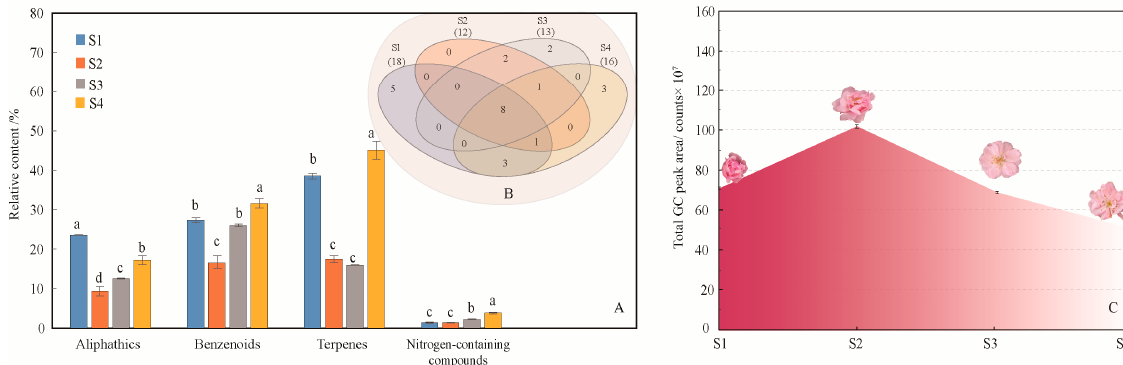
Figure 1. Generation of volatile compounds from M . ioensis “Prairie Rose” flowers during flowering. ( A ) Compounds of di ff erent chemical classes among the four flowering stages. S1 bud stage; S2 initial flowering stage; S3 flowering stage; and S4 end of flowering stage. The same letters above di ff erent color column mean there is no significant di ff erence in the same chemical class among four flowering stages ( P > 0.05), and di ff erent letters indicate significant di ff erence ( P < 0.05). ( B ) Venn diagram indicating the similarities and di ff erences in total volatile compounds among the di ff erent flowering stages. The numbers in related overlapping areas indicate the compounds shared between the di ff erent flowering stages. ( C ) Volatile compound emissions from M . ioensis “Prairie Rose” flowers during flowering.